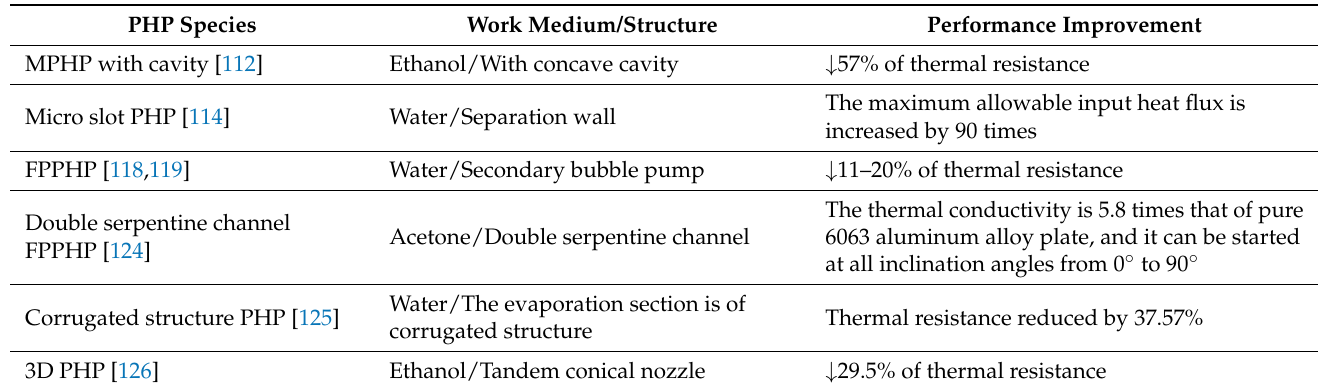
Table 3. Effect of OHP pipeline structure on